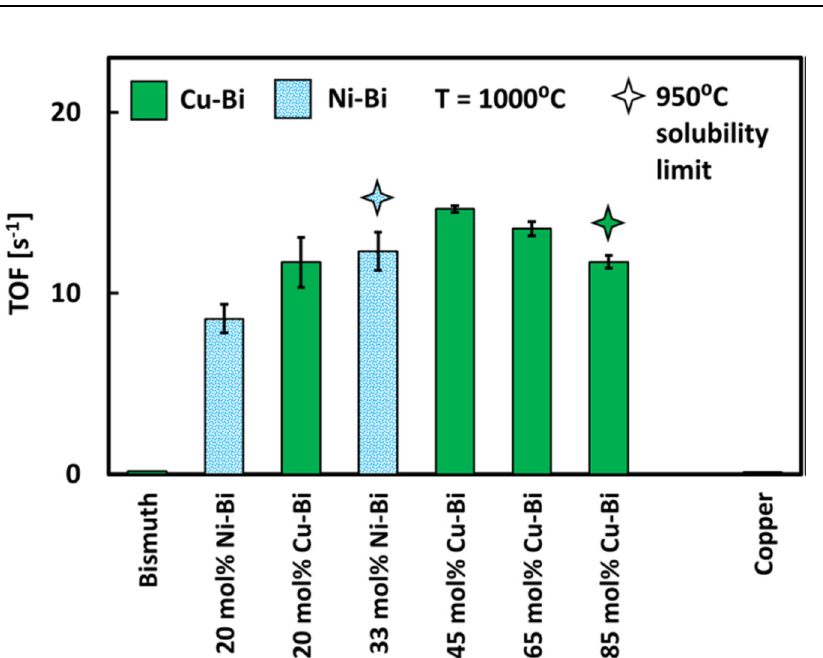
Figure 5. TOF for methane cracking over Cu–Bi, Ni–Bi alloys and pure Bi at 1000 °C. Pure copper is tested at 1100 °C (Copied from Ref. [33] with American Chemical Society permission).